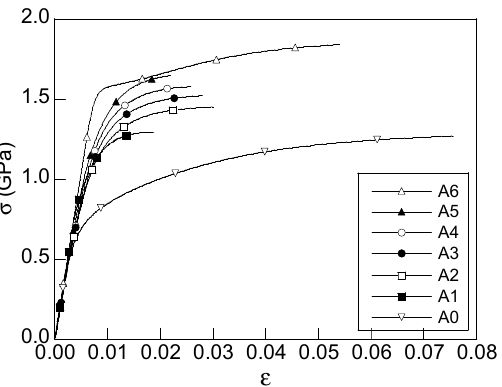
Figure 2. Stress-strain curves of the progressively drawn pearlitic steels A0 to A6 (from 0 to 6 cold-drawing steps).